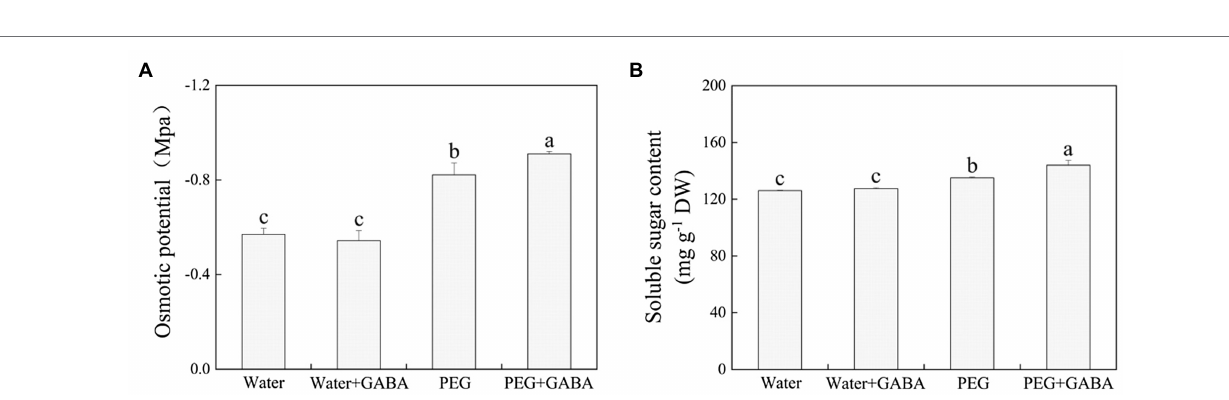
FIGURE 3 | Effects of seed priming with deionized water or γ -aminobutyric acid (GABA) on osmotic potential (OP; A ) and soluble sugar content (B) during seed germination of white clove under water